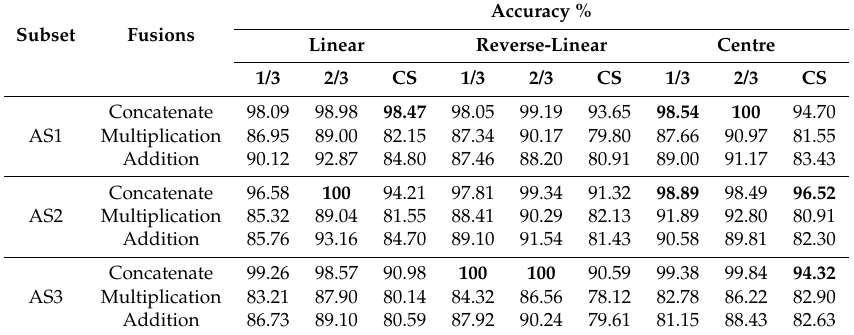
Table 10. Performance of the proposed method for different weighting functions for the FWMDMMs. Results of different fusion approaches with the spatial information (depth) are also shown. Results are for the MSR 3D action